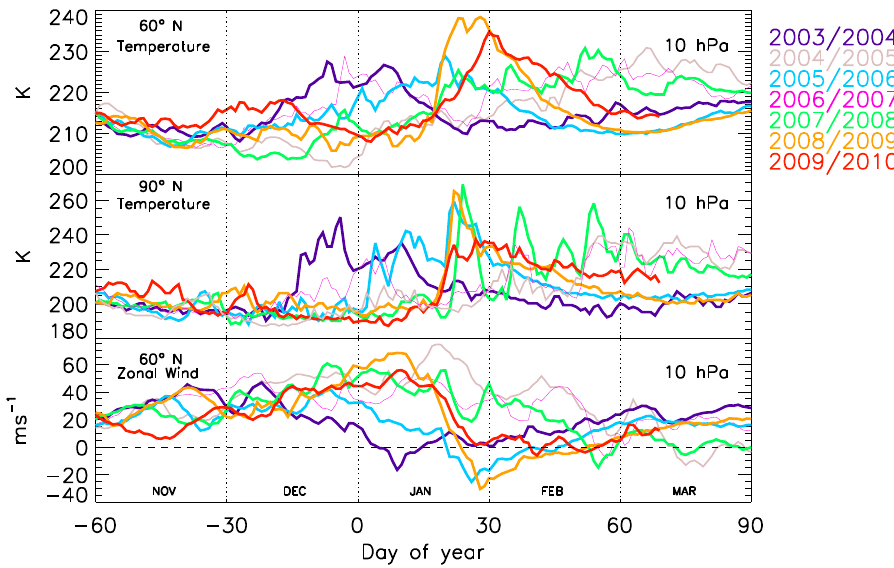
Fig. 1. Temporal evolution of the zonally averaged temperature and zonal wind in the ECMWF operational analysis for the Arctic winters 2003/04–2009/10. The dashed horizontal line represents 0ms − 1 and the dotted vertical lines separate each month.